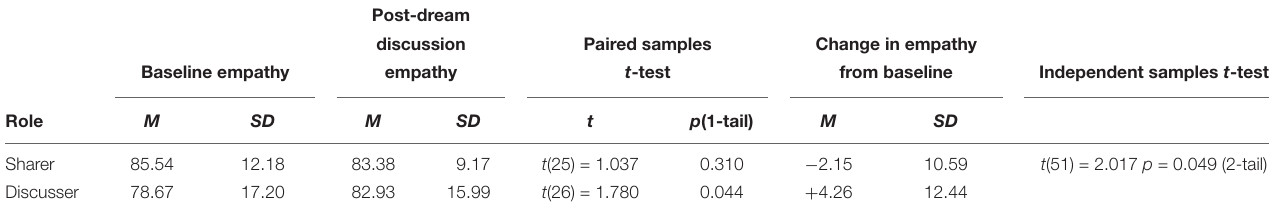
TABLE 6 | Baseline and post-dream discussion empathy of dream sharer ( n = 26) and dream discusser ( n = 27) toward each other, and change in empathy from baseline for sharer and discusser. Post-dream discussion Paired